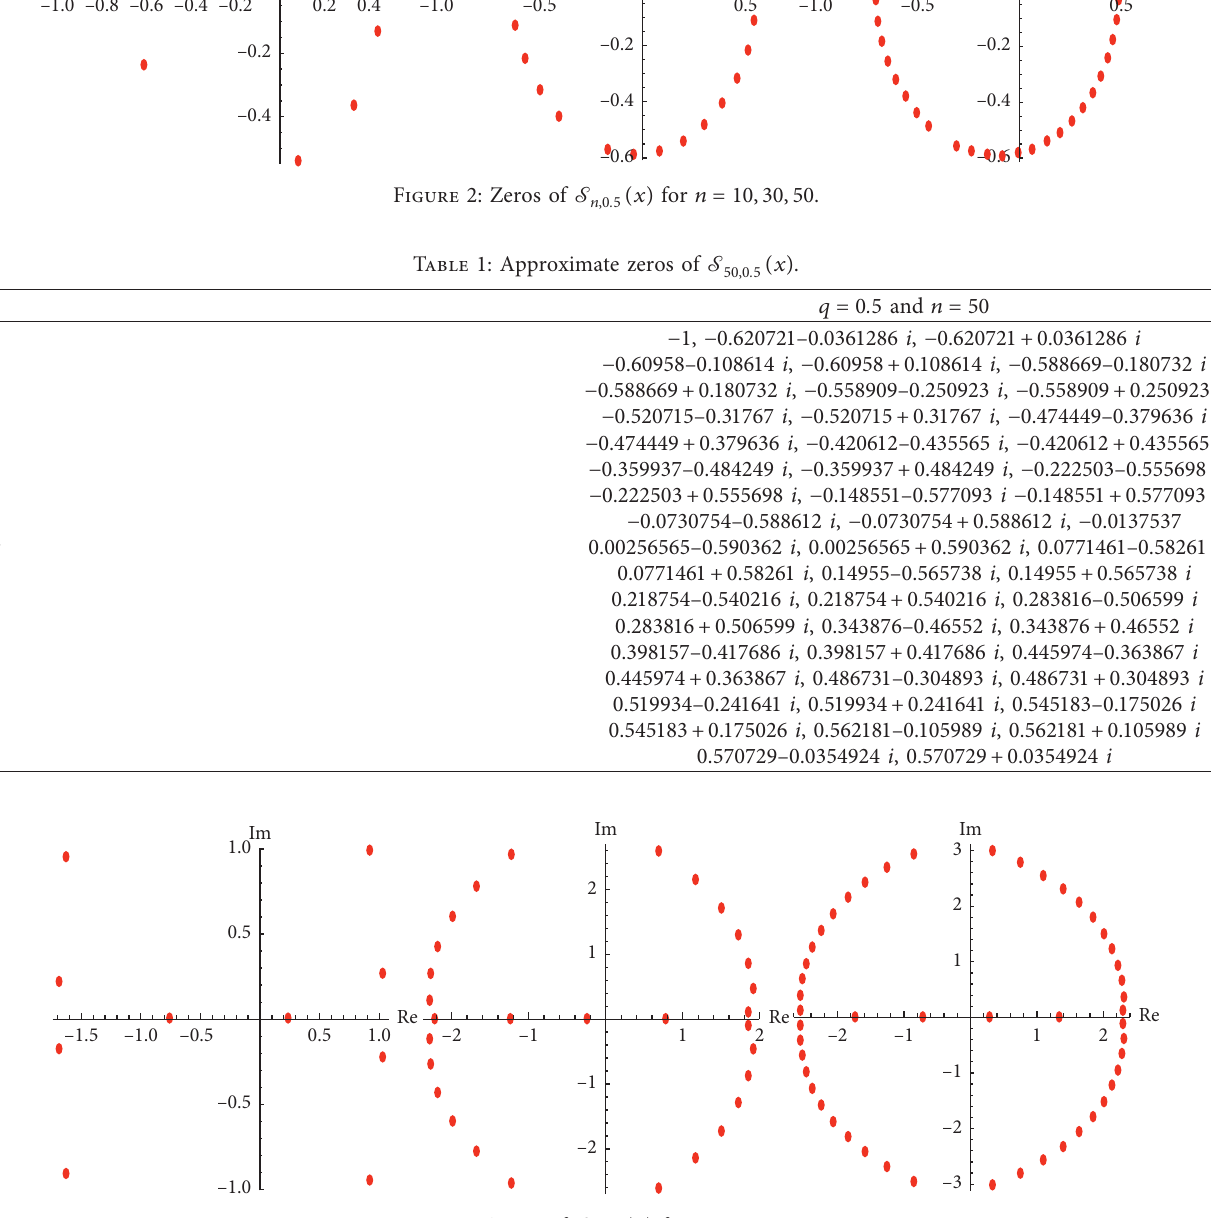
( x ) for n � 10 , 30 , n, 0 . 9